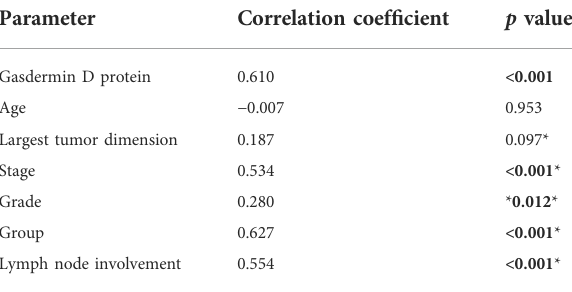
TABLE 7 Correlation between gasdermin D gene expression and the other parameters: Parameter Correlation coef fi